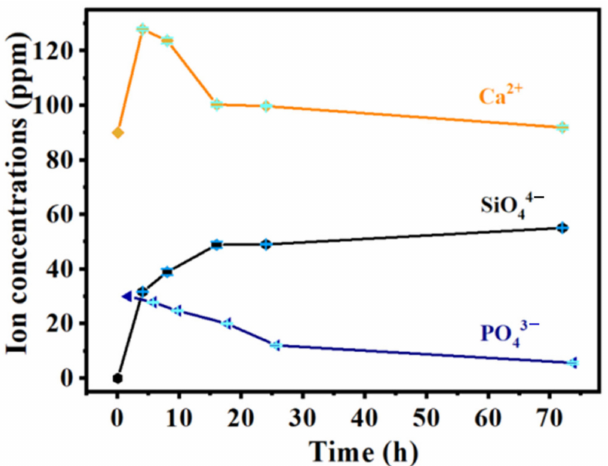
Figure 8. The curves of ion concentration released from MBG nanofiber scaffold for different time periods.